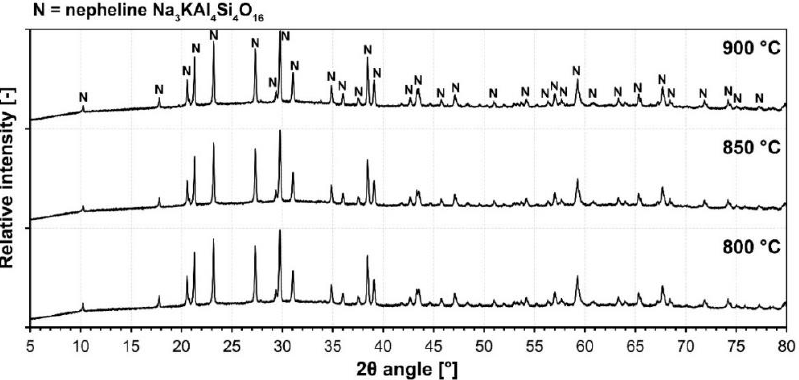
Figure 6. Examples of XRD patterns of waste diatomite foams fired at different temperatures (samples with pretreatment temperature 50 °C shown). Figure 7a–f. represents the SEM microphotographs of foamed waste diatomite